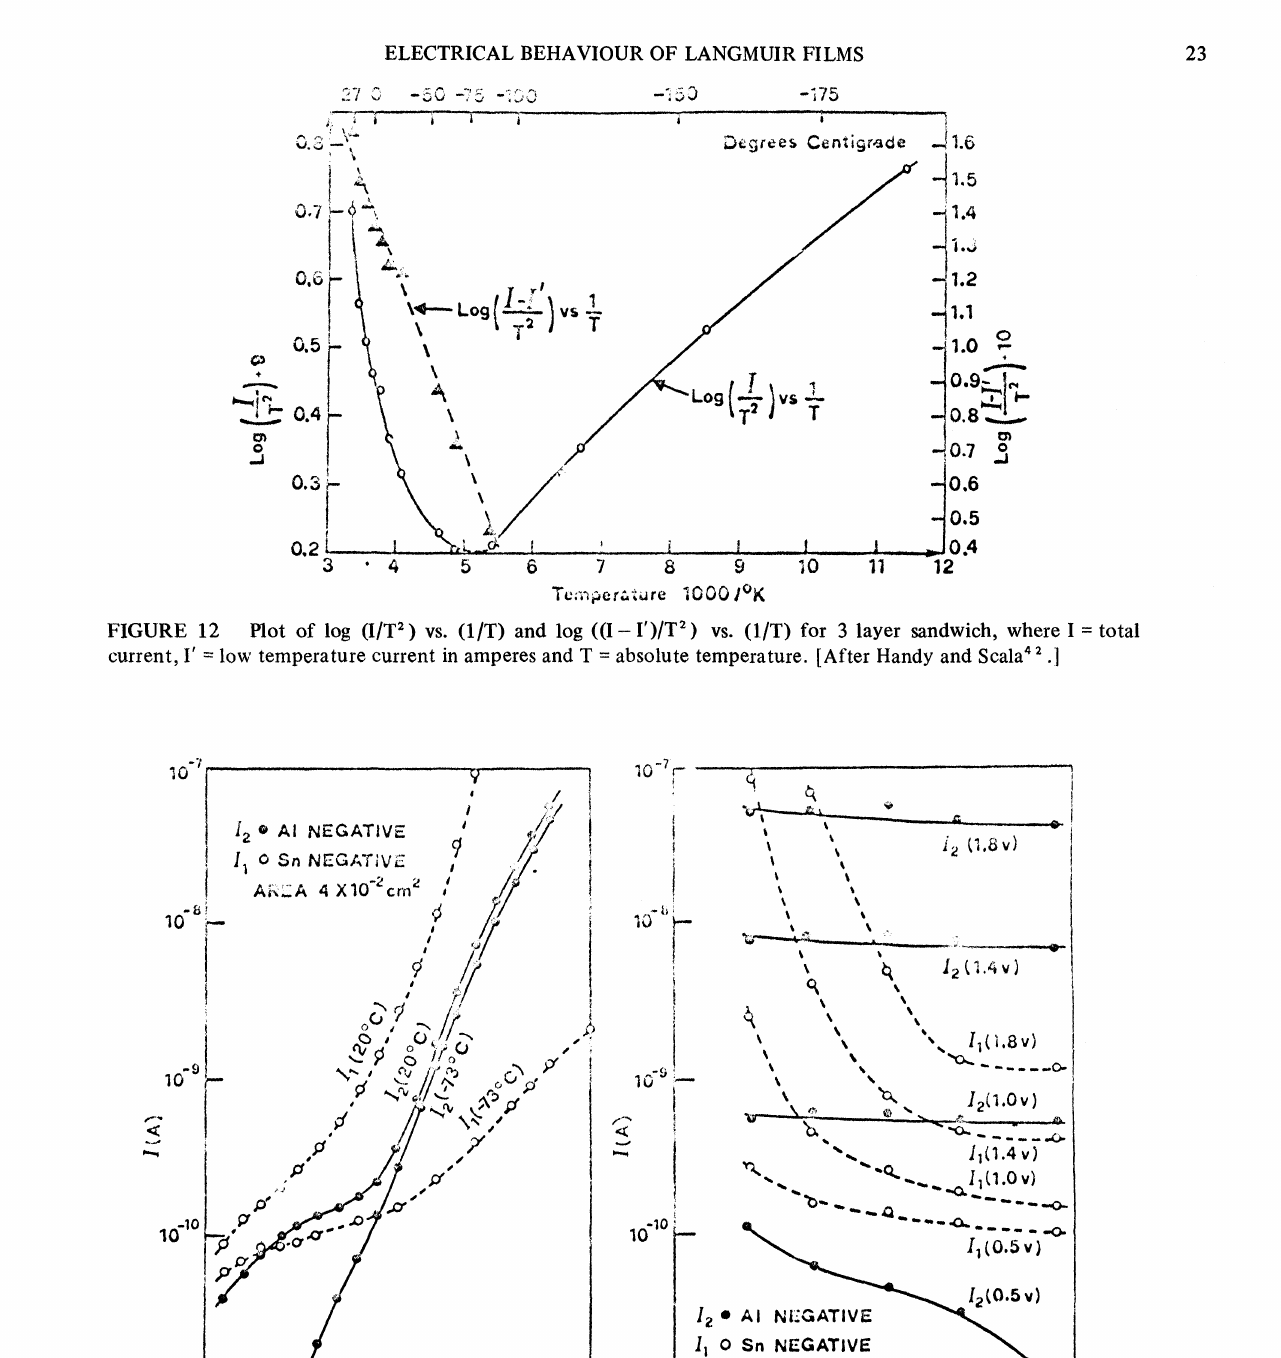
FIGURE 13 (a) Plot of 11 and I: vs. V at fixed temperature for Sn 3 layer Ca stearate-A1 junctions; and (b) plot of 11 and I vs. 1/T at fixed voltage for Sn-Ca stearate junctions. Black dots and white circles represent 12 and 11 respectively. [After Horiuchi et al